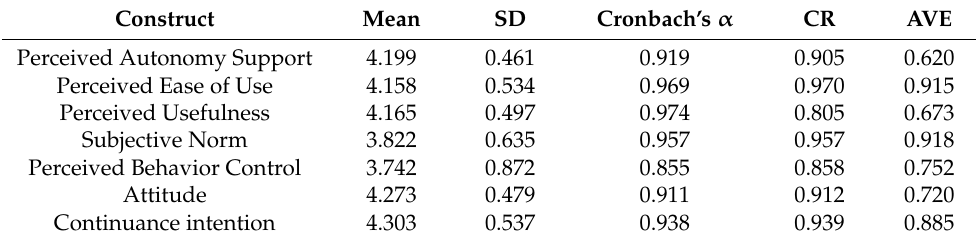
Table 2. Measurement Model